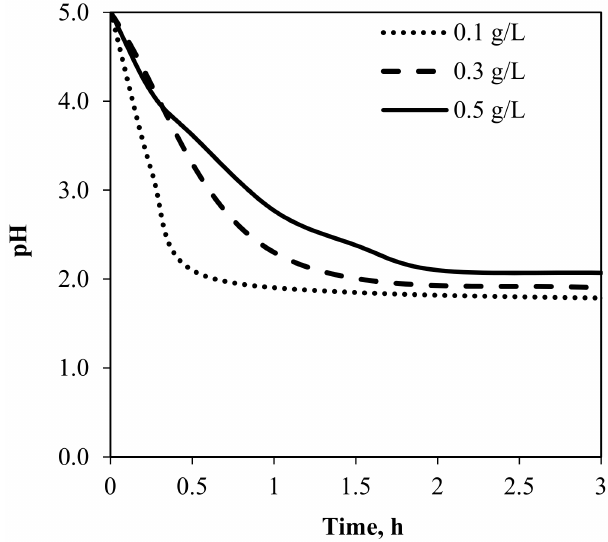
Figure 7. The pH changes in the feed phase during the Cr(III) ion extraction for optimum carrier proportion in DCSLM. Table 11. The experimental conditions, value of response predicted by model and experimental results, and statistical parameters. No. of